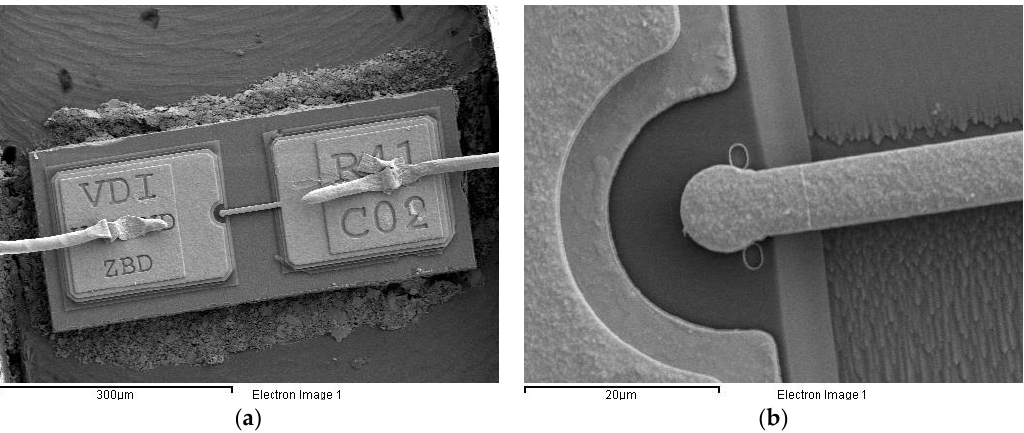
Figure 1. ( a ) General View of the ZBD using SEM (Dice about 600 × 250 µm; anode finger length about 100 µm). ( b ) Detail of the anode finger of the ZBD (diameter about 9 µm). Reference scale is at the bottom of the figures.